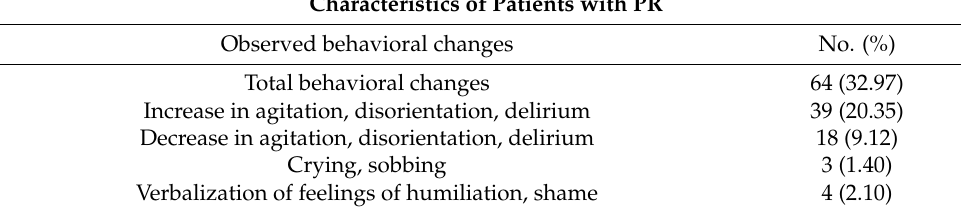
Abbreviations: PR: physical restraint; no.: number; AAs: artificial airways; VM: mechanical ventilation; ETT: endotracheal tube; NIMV: non-invasive mechanical ventilation; UE: upper extremities; LE: lower extremities; ICU: intensive/critical care